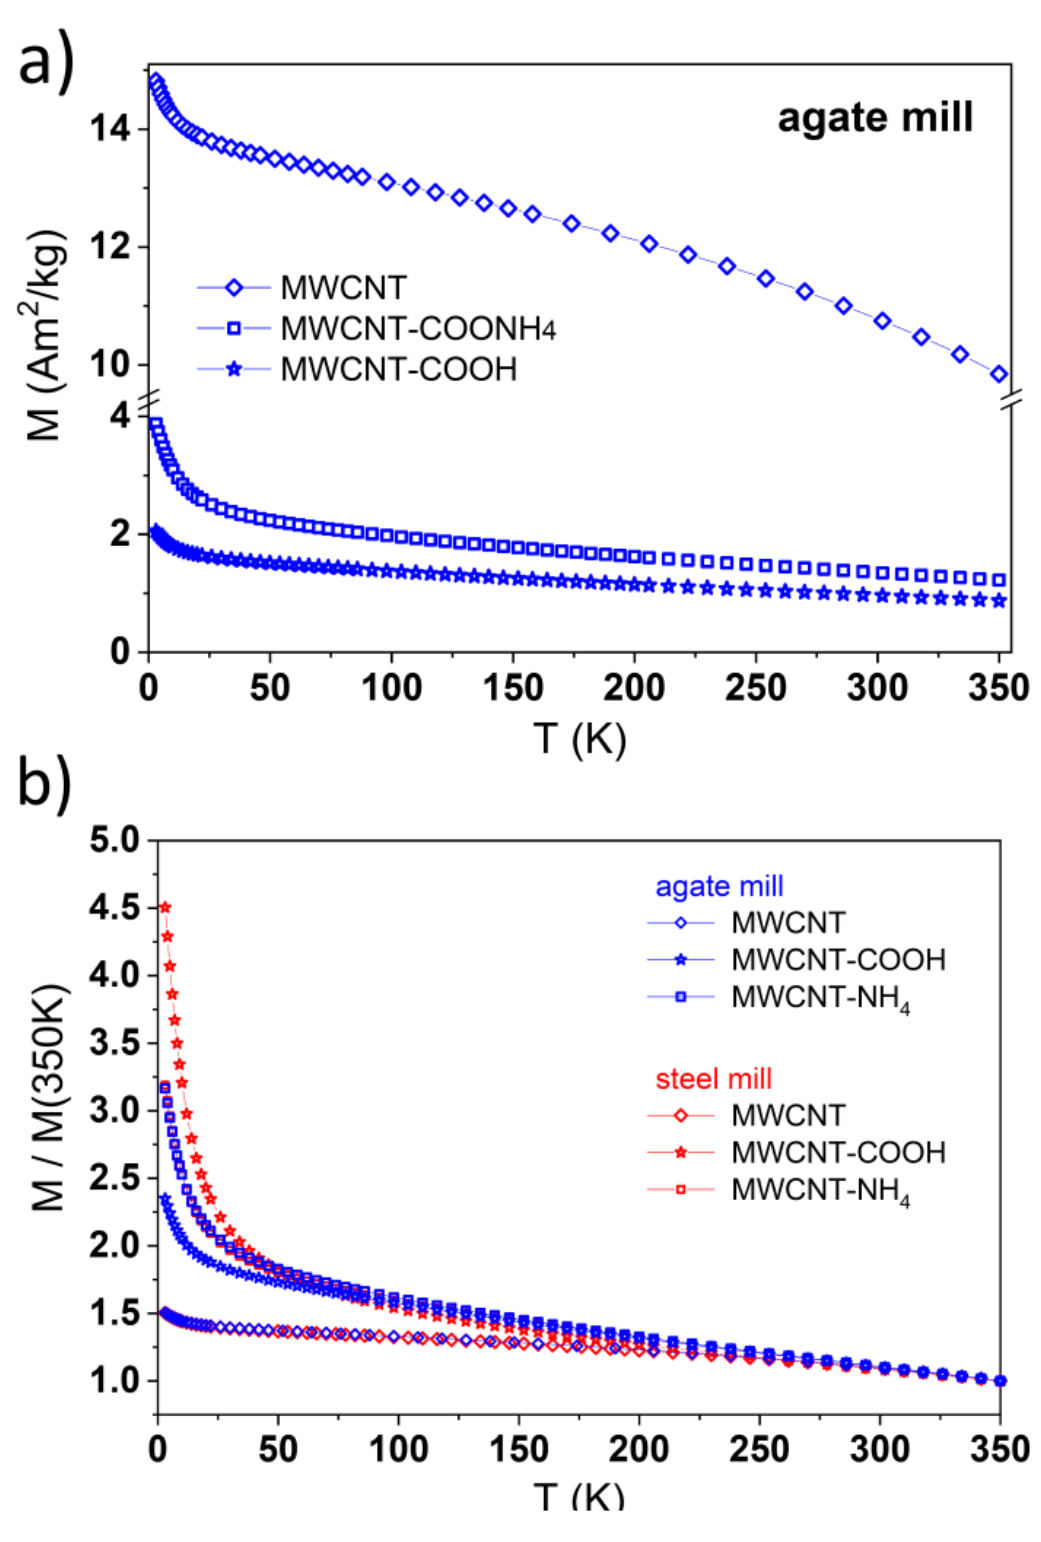
Figure 4. ( a ) Temperature dependences of corrected magnetization ( M ) measured in the field of 4 T for MWCNT (diamonds), and MWCNT-NH 4 (squares) and MWCNT-COOH (stars) obtained from MWCNTs prepared in agate (squares) mills. ( b ) Magnetization normalized to its value at 350 K measured in the field of 4 T for MWCNT (diamonds), and MWCNT-NH 4 (squares) and MWCNT-COOH (stars) obtained from MWCNTs prepared in the agate (blue) and steel (red) mill.